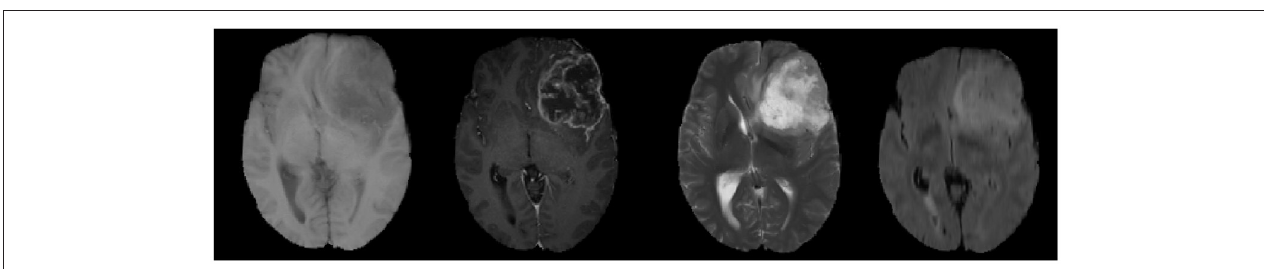
FIGURE 6 | MRI images of four different